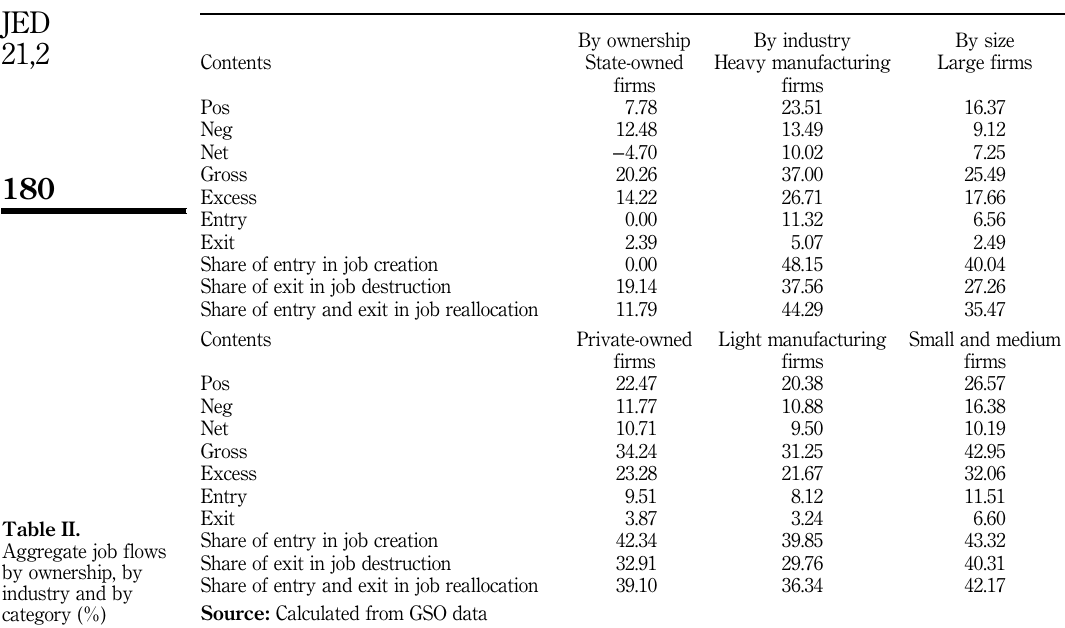
Table II. Aggregate job flows by ownership, by industry and by category